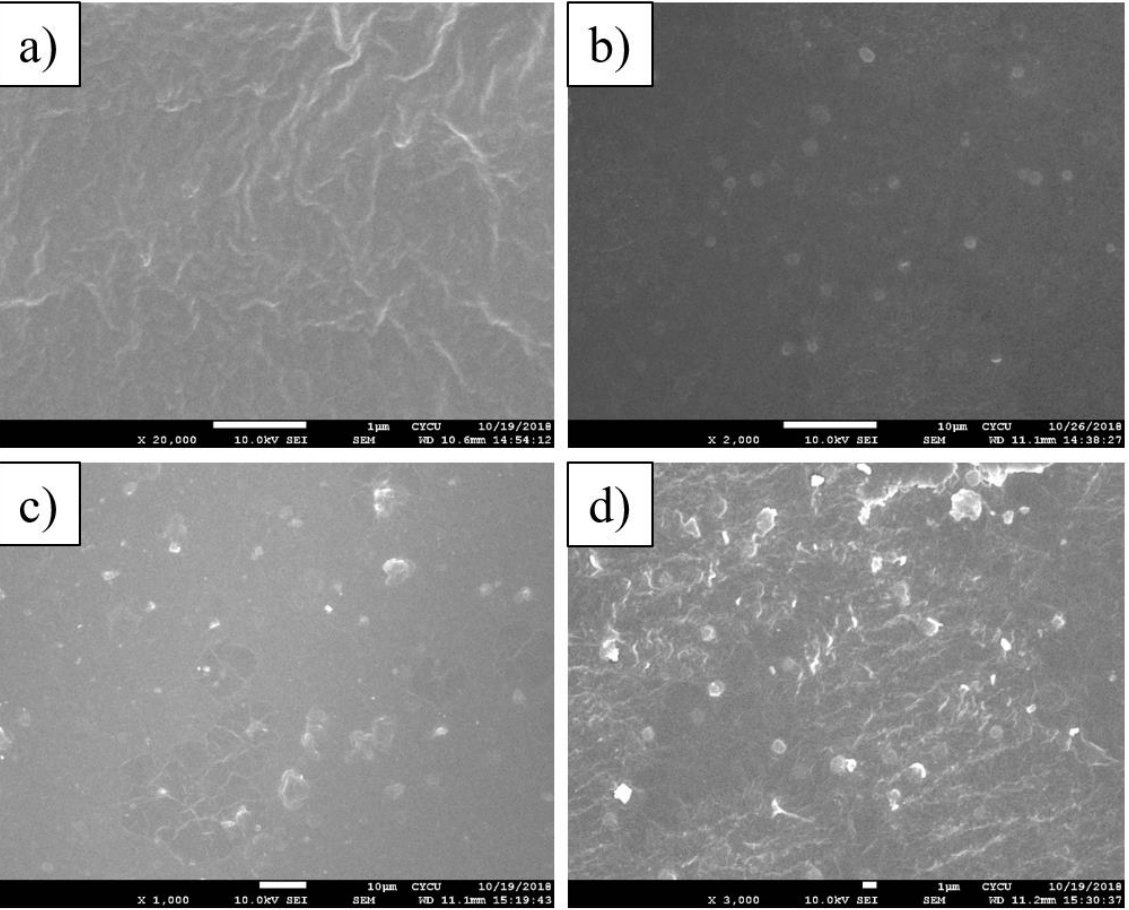
Figure 3. SEM image for P-Z5(dry-free) [( a ):surface, ( b ):cross-section] and P-Z5(Dried) [( c ):surface, ( d ):cross-section].